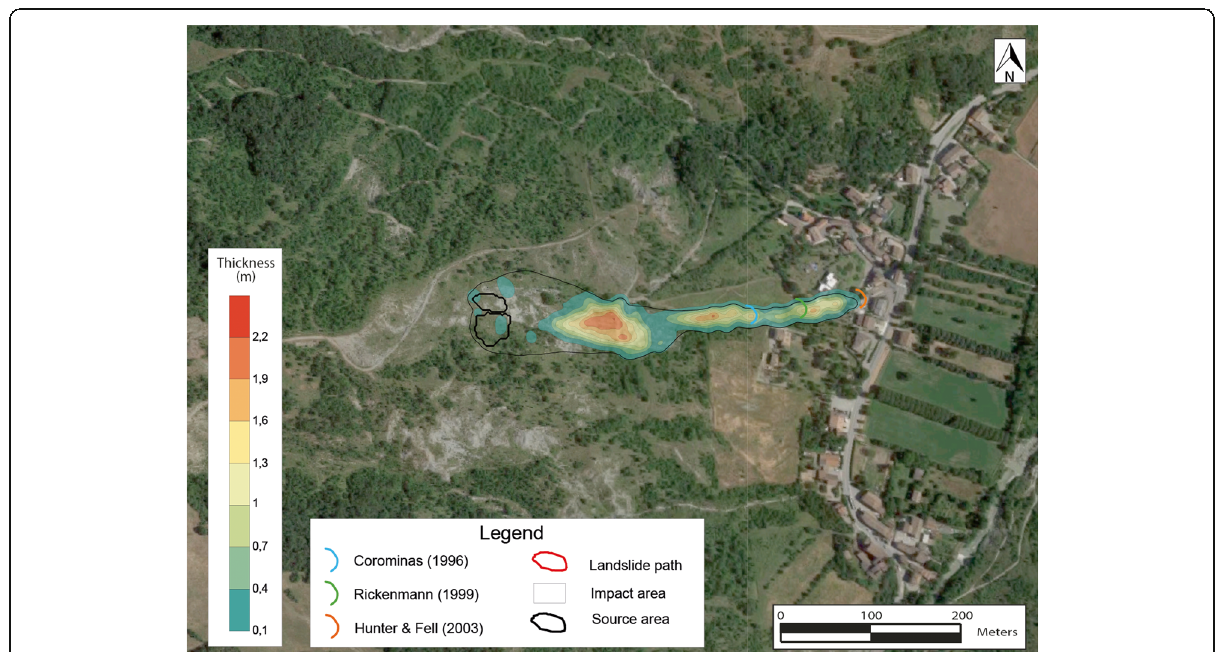
Fig. 13 Comparison between the maximum runout distances obtained from the empirical and numerical methods with the field data (in